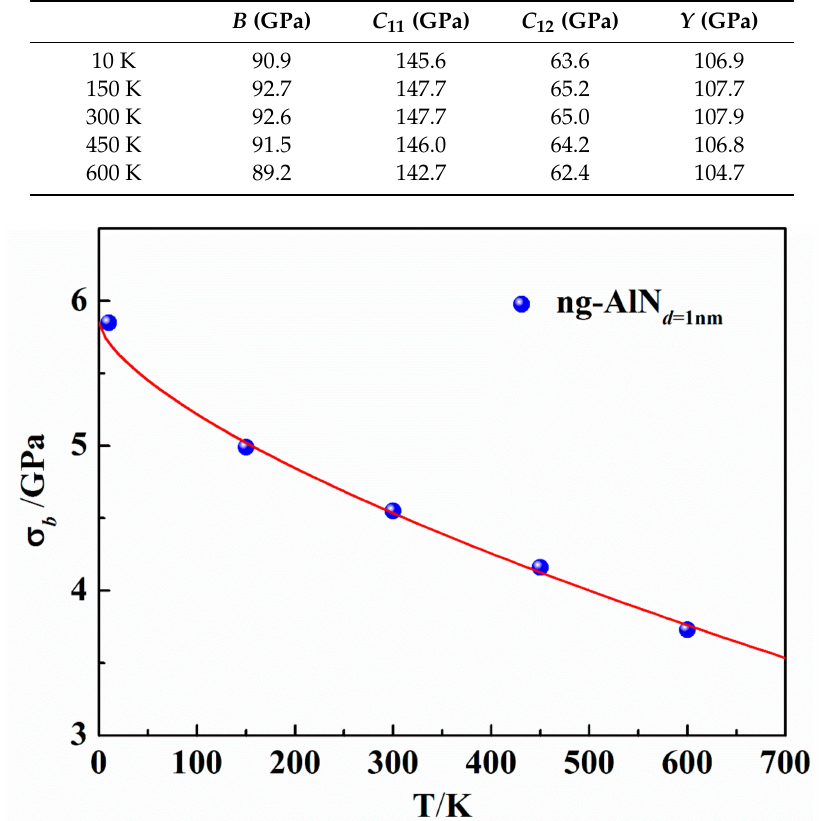
Figure 6. Tensile stress-strain ( σ − ε ) curves for ng-AlN d = 1 nm under di ff erent temperatures. Table 2. Mechanical properties of ng-AlN d = 1 nm at di ff erent temperature (10 K, 150 K, 300 K, 450 K, and 600 K) obtained with the MD simulations.